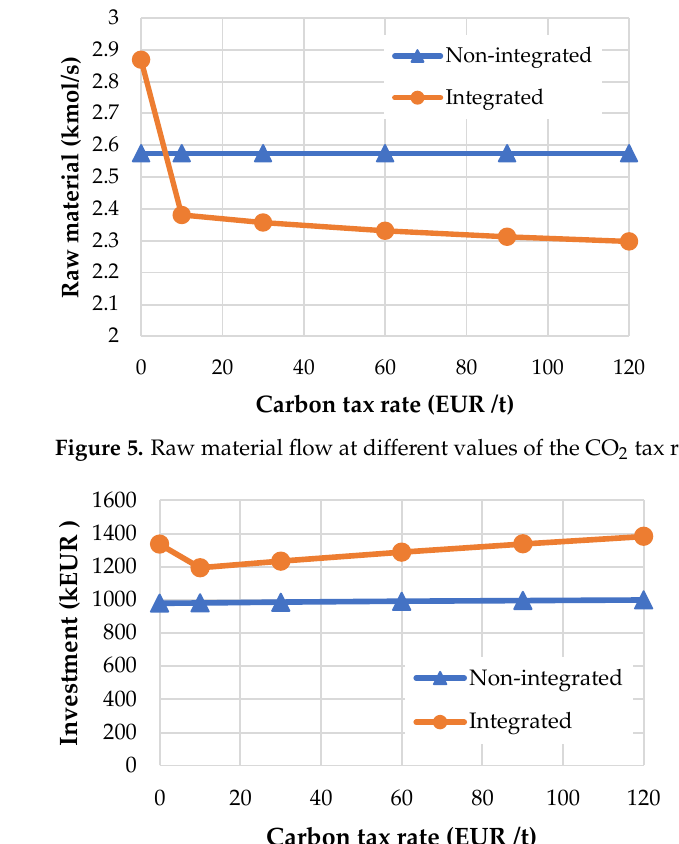
Table 3. Results of the one-period process synthesis at different values of CO 2 tax.